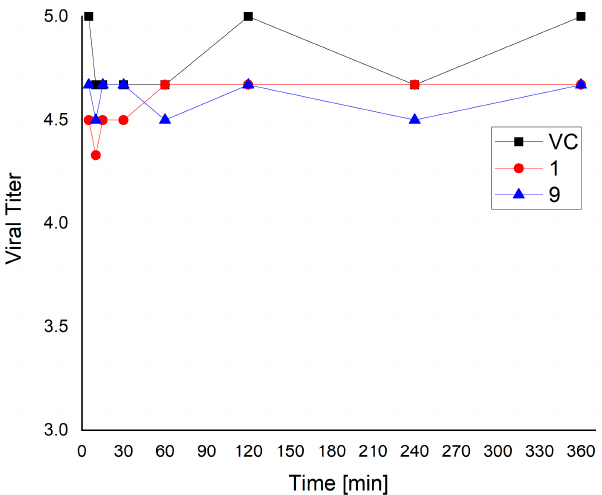
Figure 3. Virucidal activity of CFSs from KC5-12 and KZM2-11-3 against HHV-2.